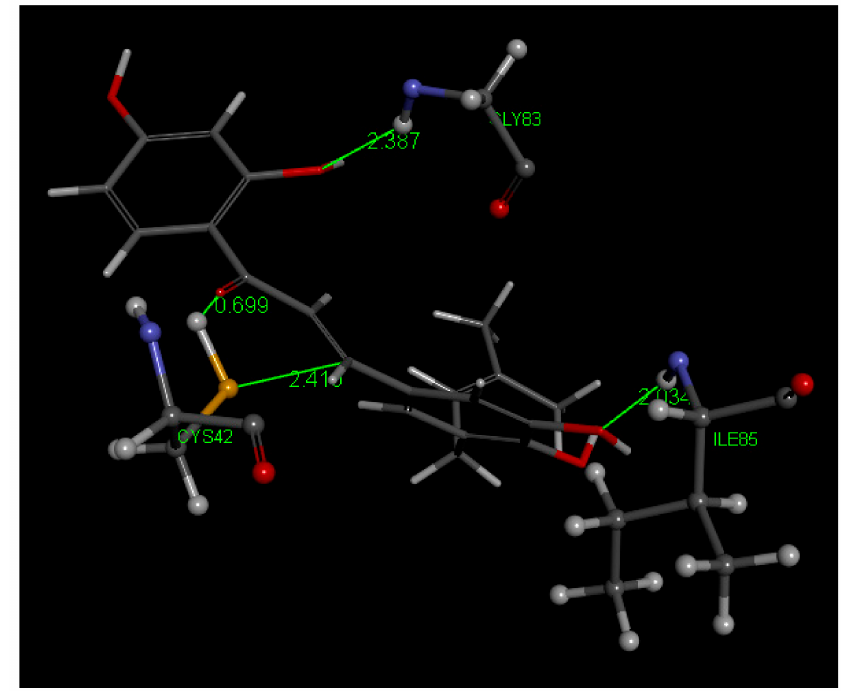
Figure 28. 5-Prenylbutein ( 4 ) in the 3BPF receptor, pose 3, after calculating binding energies. S(Cys42) establishes a covalent bond with C(ethenyl) β carbon, 2.410 Å, and there is capture of H[S(Cys42)] by O(carbonyl). An additional interaction is established by Gly40, which makes a π amide stack, omitted for clarity.